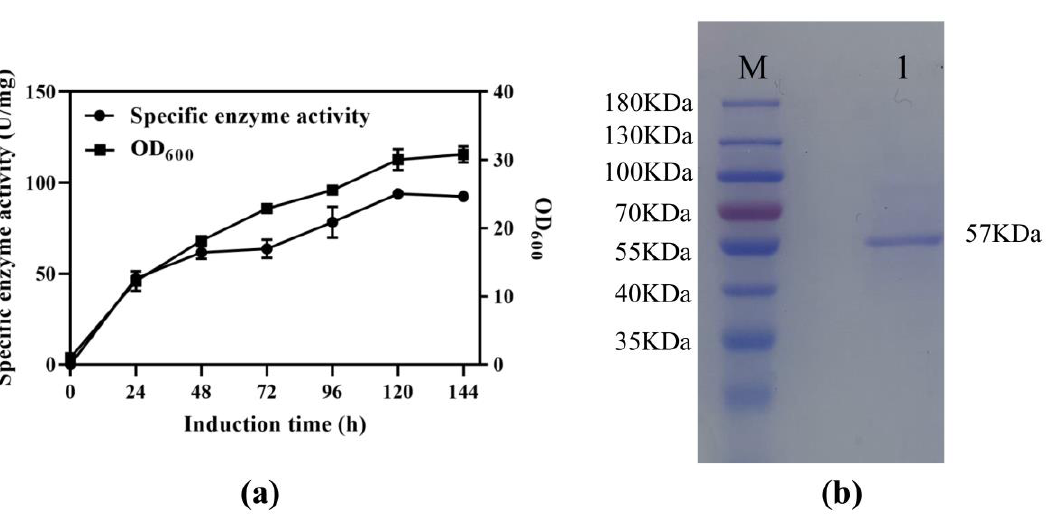
Figure 1. Expression of SS-bgly in P. pastoris . ( a ) Fermentation time curve of recombinant SS-bgly in P. pastoris . ( b ) SDS-PAGE analysis. Lane M: marker, Lane 1: recombinant